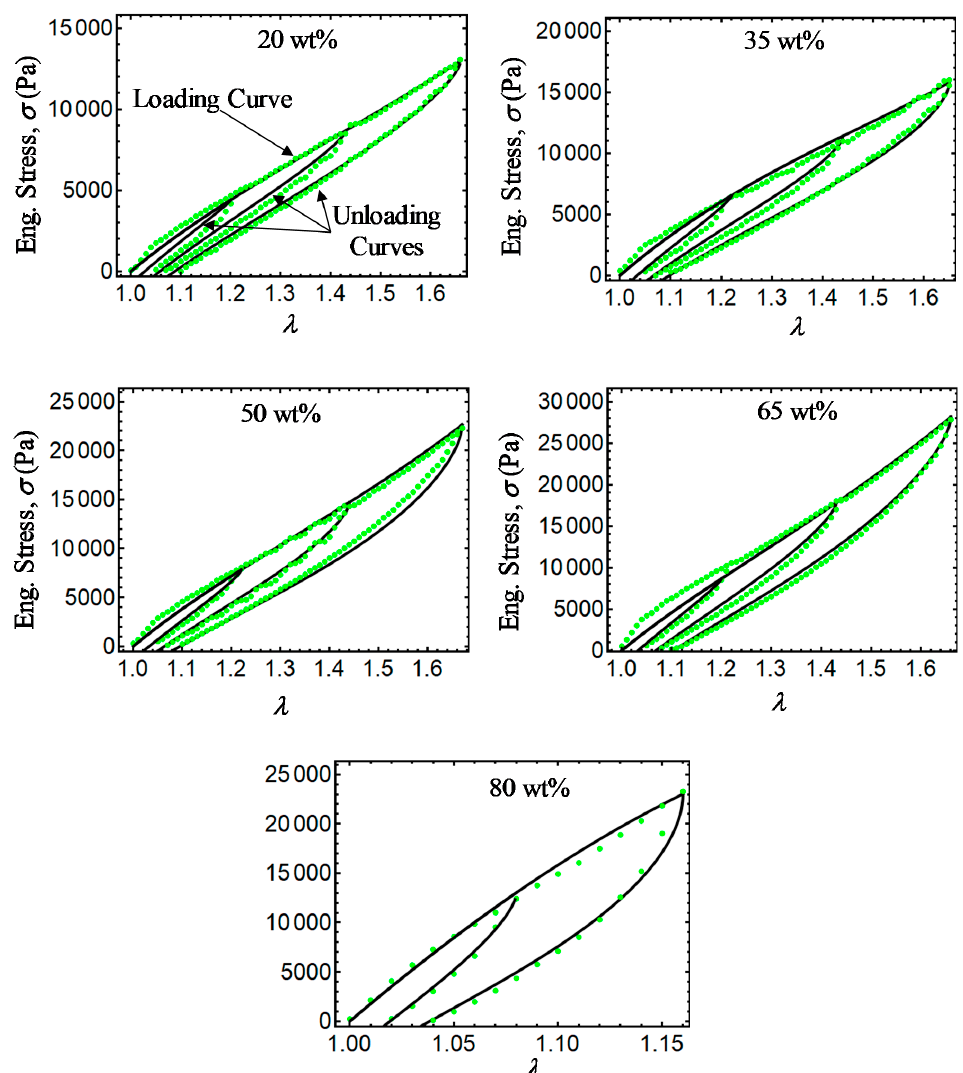
Figure 12. Engineering stress–stretch curves for isotropic magnetorheological material samples with B = 52.2 mT. Here, the blue dots describe experimental data while the black solid lines are theoretical predictions obtained from Equations (28) and (31).